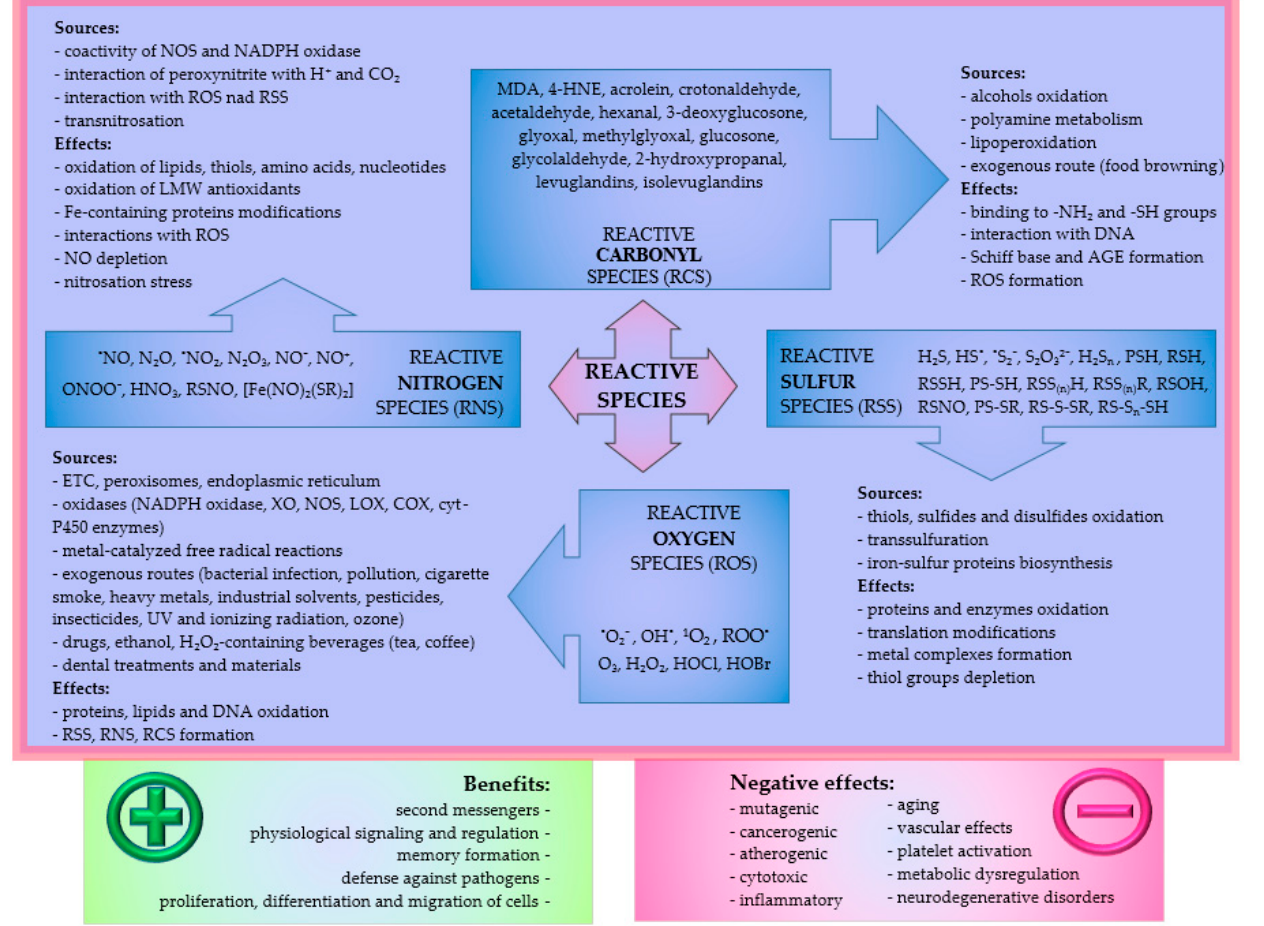
Figure 1. Reactive species, their sources and effects. Legend: NO-nitric oxide, NOS-nitric oxide synthase, NADPH-oxidase-nicotinamide adenine dinucleotide phosphate oxidase, LMW-low molecular weight, XO-xanthine oxidase, LOX-lipooxygenase, COX-cyclooxygenase, AGE-advanced glycation end products, MDA-malondialdehyde, 4-HNE-4-hydroxynonenal.